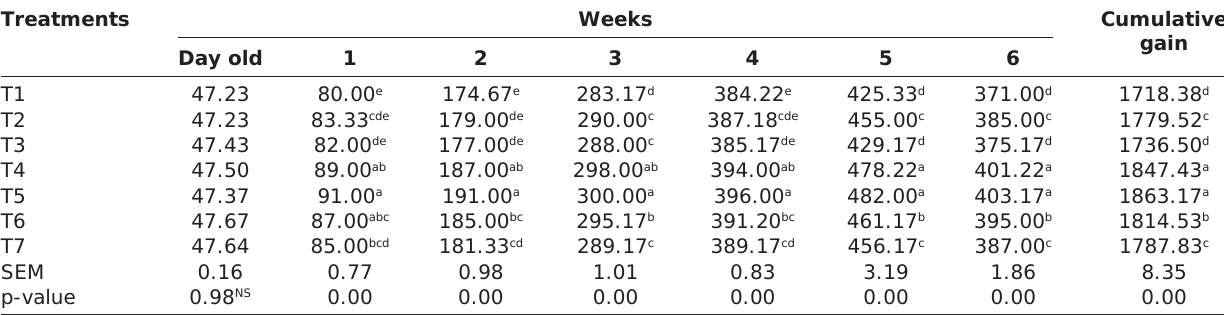
Table-1: Effect of supplementing garlic and NLPs and their combinations on weight gain of broilers. Treatments